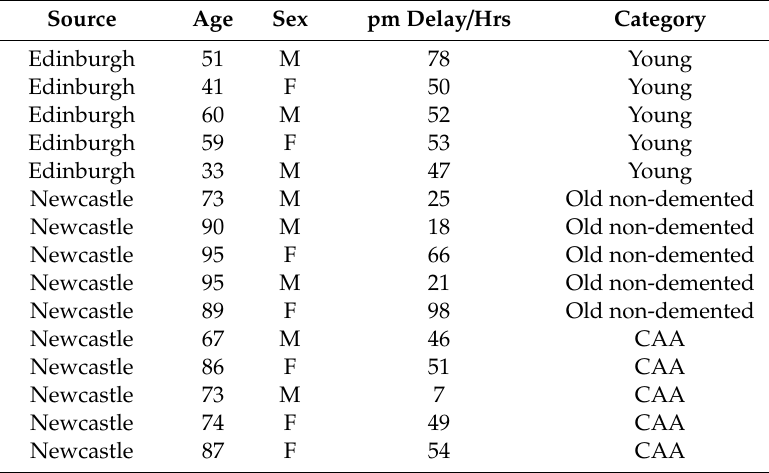
Table 2. Demographics for the cases